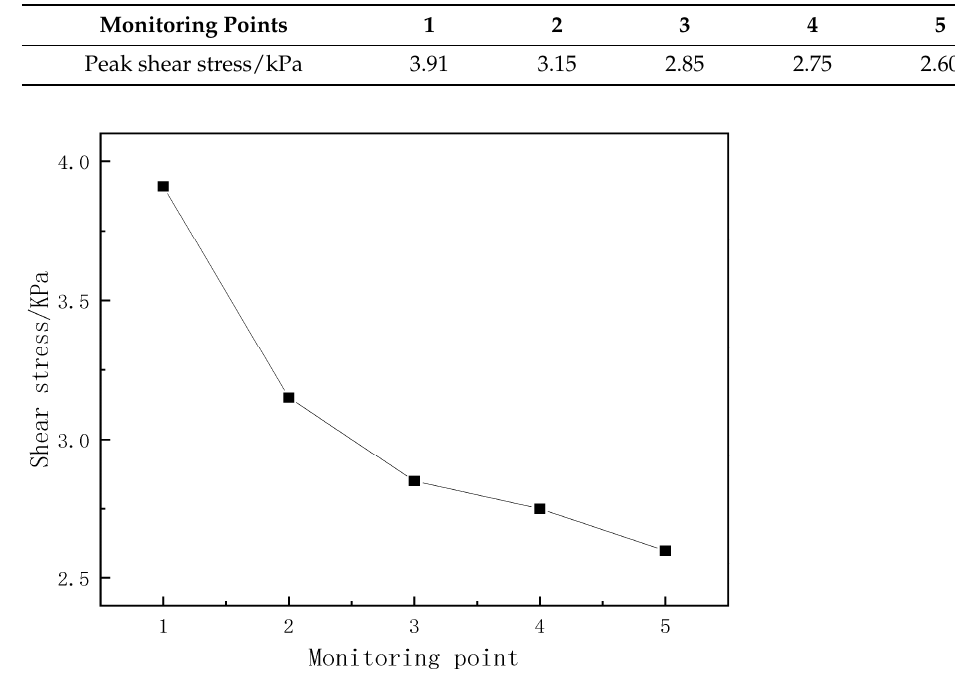
Figure 16. Peak horizontal radial shear stress diagram at an elevation of 20 m.